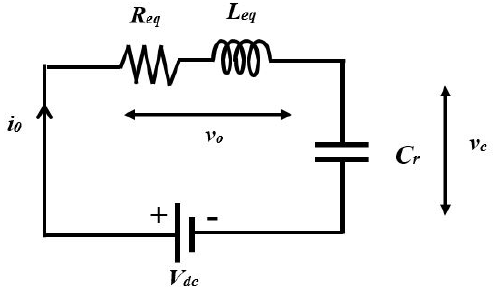
Figure 4. Equivalent circuit of SRI-fed IH